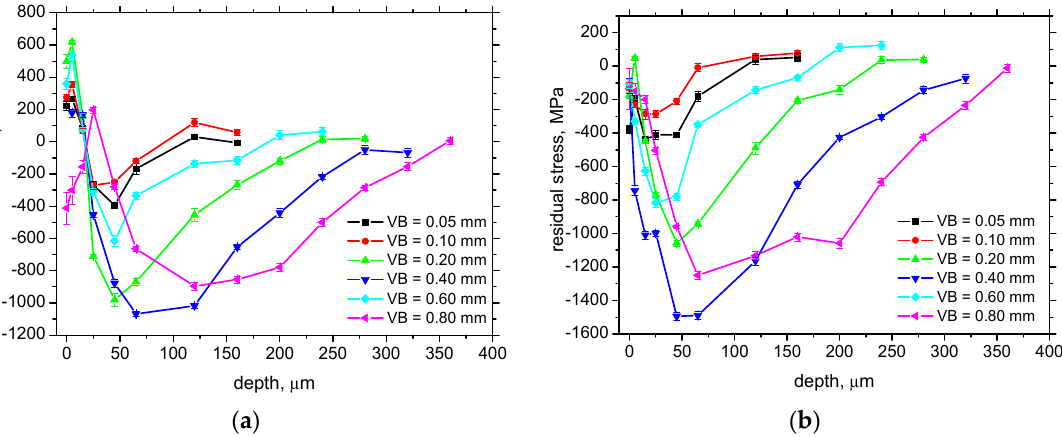
Figure 7. Depth profiles of residual stresses for cutting speed 100 m.min − 1 (bulk stress 67 ± 12 MPa): ( a ) CD; ( b ) FD.